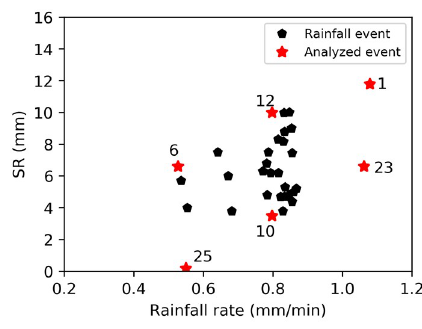
Figure 5. The relationship between rainfall rate and SR (Surface Runoff).